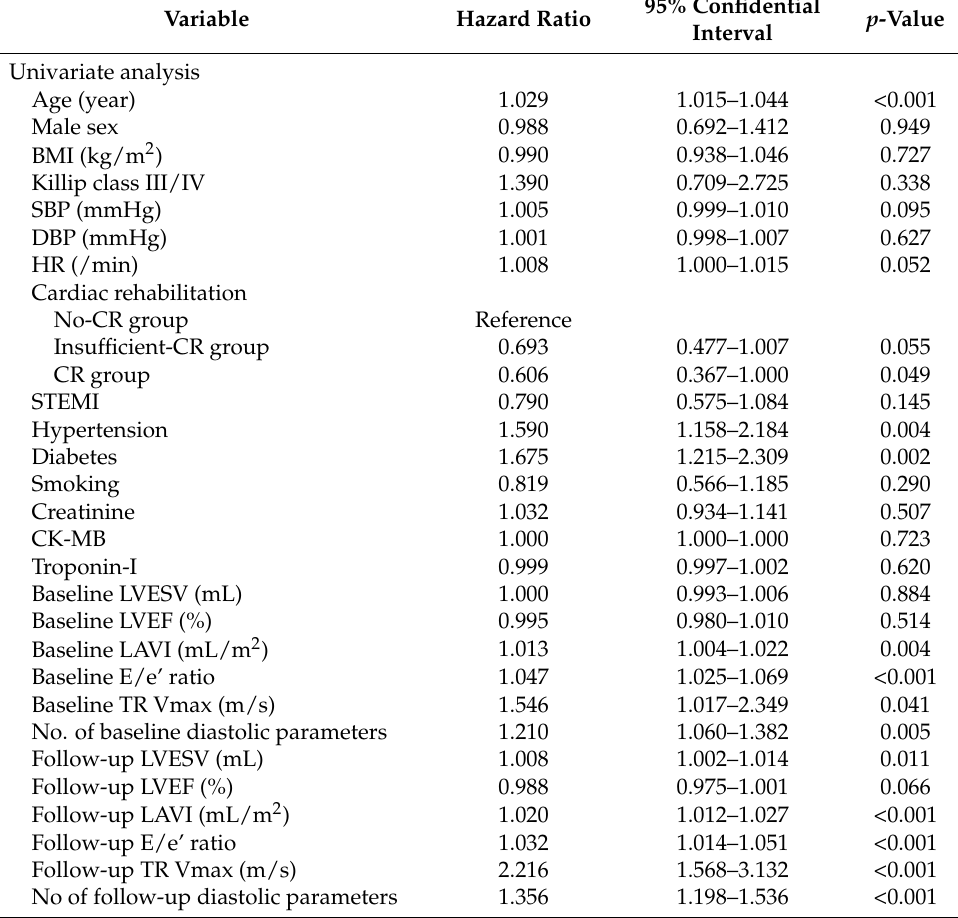
Table 4. Predictors of major adverse clinical